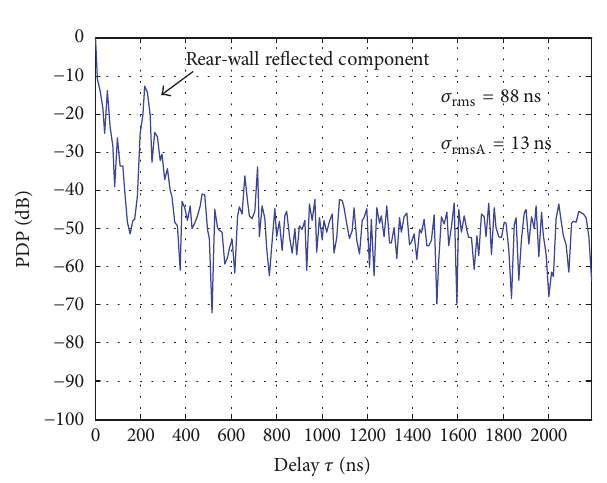
Figure 10: PDP at 35 m.